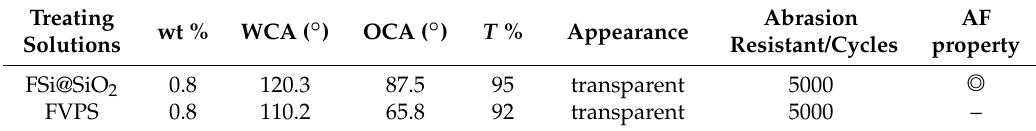
Table 1. Performance of the FSi@SiO 2 coating.